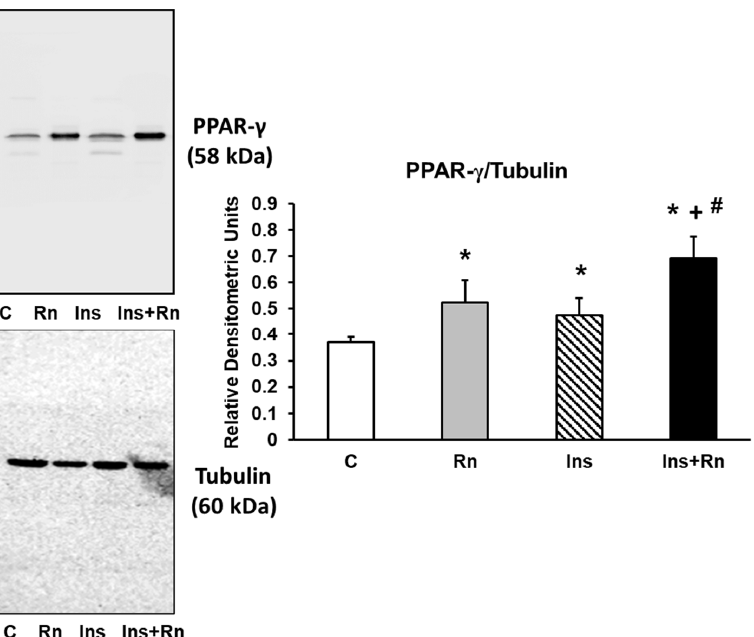
Figure 9. Effect of Ins and Rn on PPAR- γ protein expression. Astrocytes were incubated without Ins or Rn (control, C), with Rn (10 − 6 M), with Ins (10 − 8 M), or with Ins + Rn (10 − 8 M + 10 − 6 M) for 24 h and collected to determine PPAR- γ (1:300) and Tubulin (1:3000) protein expression by Western blot. A representative immunoblot is shown in the top panel. Data are mean ± SD of four independent experiments (four different rats). * p < 0.05 vs. control. + p < 0.05 vs. Rn. # p < 0.05 vs. Ins.